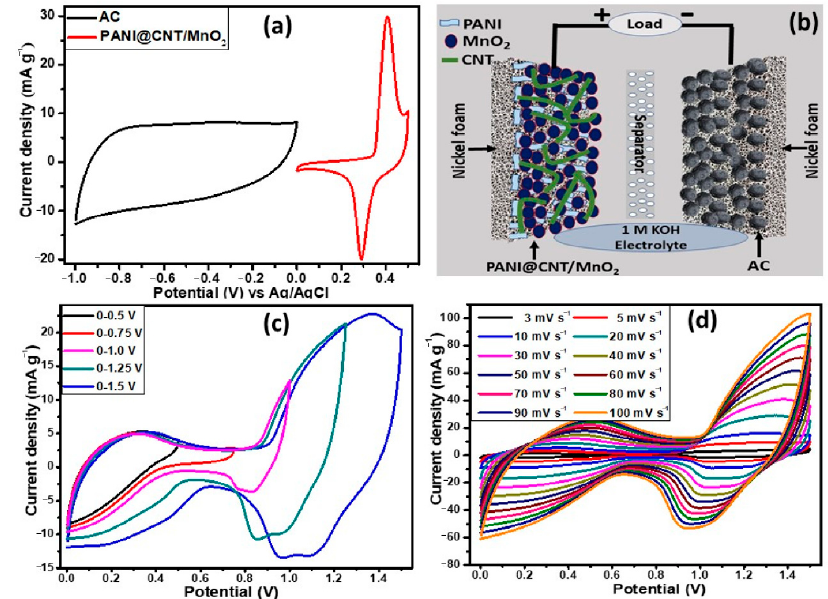
Figure 8. ( a ) Comparative cyclic voltammetry (CV) curves of PANI@CNT / MnO 2 ternary composite and activated carbon (AC) electrodes performed in a three-electrode cell in KOH aqueous solution at a scan rate of 10 mV s − 1 ; ( b ) graphical representation of assembled device; ( c ) CVs of PANI@CNT / MnO 2 // AC supercapattery measured at di ff erent potential windows; and ( d ) galvanostatic charge–discharge curves of PANI@CNT / MnO 2 // AC supercapattery at various current